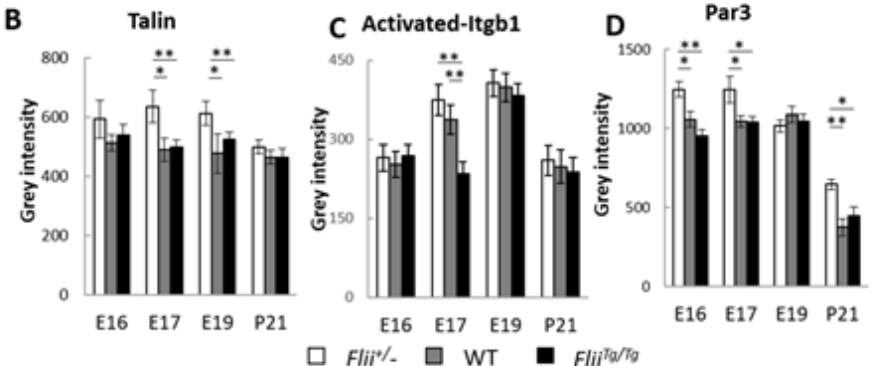
Figure 8. Expression of talin, activated-Itgb1 and Par3 in the epidermis of mice expressing varying levels of Flii during late embryonic development. ( A ) Immunofluorescence of talin and activated- Itgb1 in developing epidermis at E17 and Par3 at E16. Talin, Itgb1 and Par3 are shown as pseudo- stained green. Nuclear DAPI staining is shown as pseudo-stained blue. The epidermal-dermal junction is shown by white dash lines; e, epidermis; d, dermis. Scale bars, 10 μ m. Flii +/ − , Flii knockdown; WT, wild-type; Flii Tg / Tg , Flii overexpressing. Quantification of ( B ) Talin expression ( C ) Itgb1 expression and ( D ) Par3 expression as grey intensity in the epidermis at E16, E17, E19 and P21. N = 6. Mean ± SEM. * p < 0.05. ** p < 0.005.